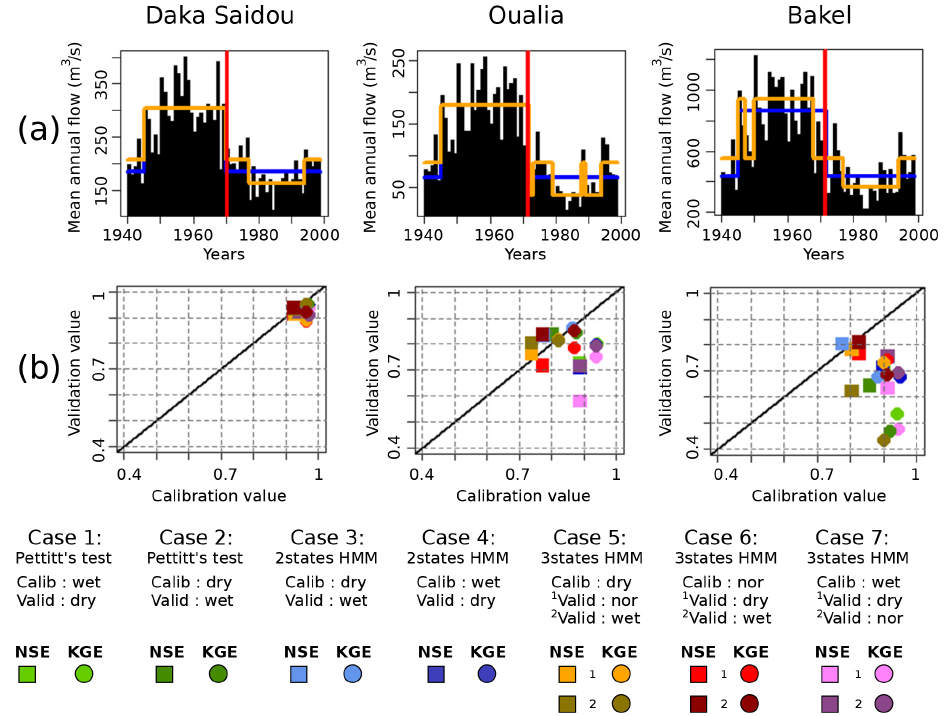
Figure 6. The full historical record T 1940–1998 . (a) Classifications of T 1940–1998 according to the Pettitt test (vertical red lines), two-state HMM (in blue), and three-state HMM (in orange); (b) scatterplot of NSE (squares) and KGE (dots) calibration/validation values. The continuous black line refers to the Calibration Value = Validation Value